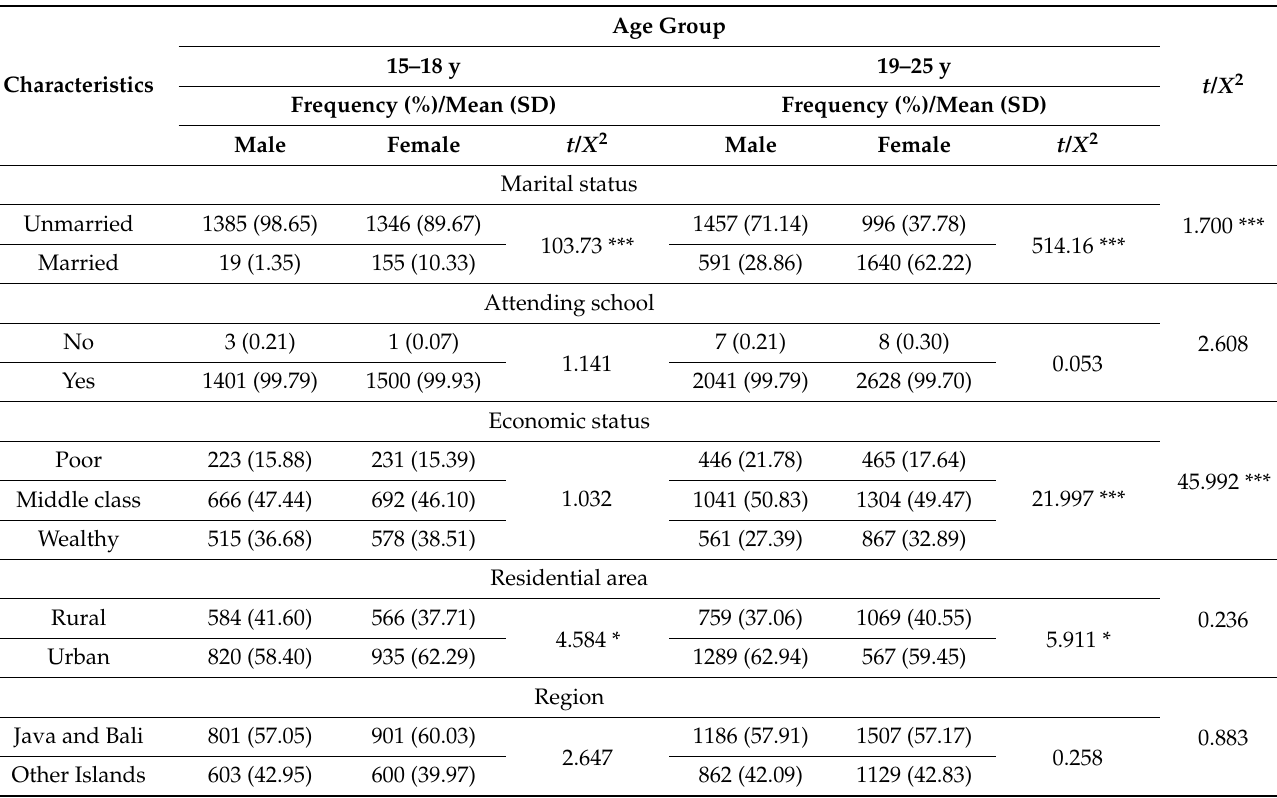
Table 1. Comparison of Personal Characteristics by Age and